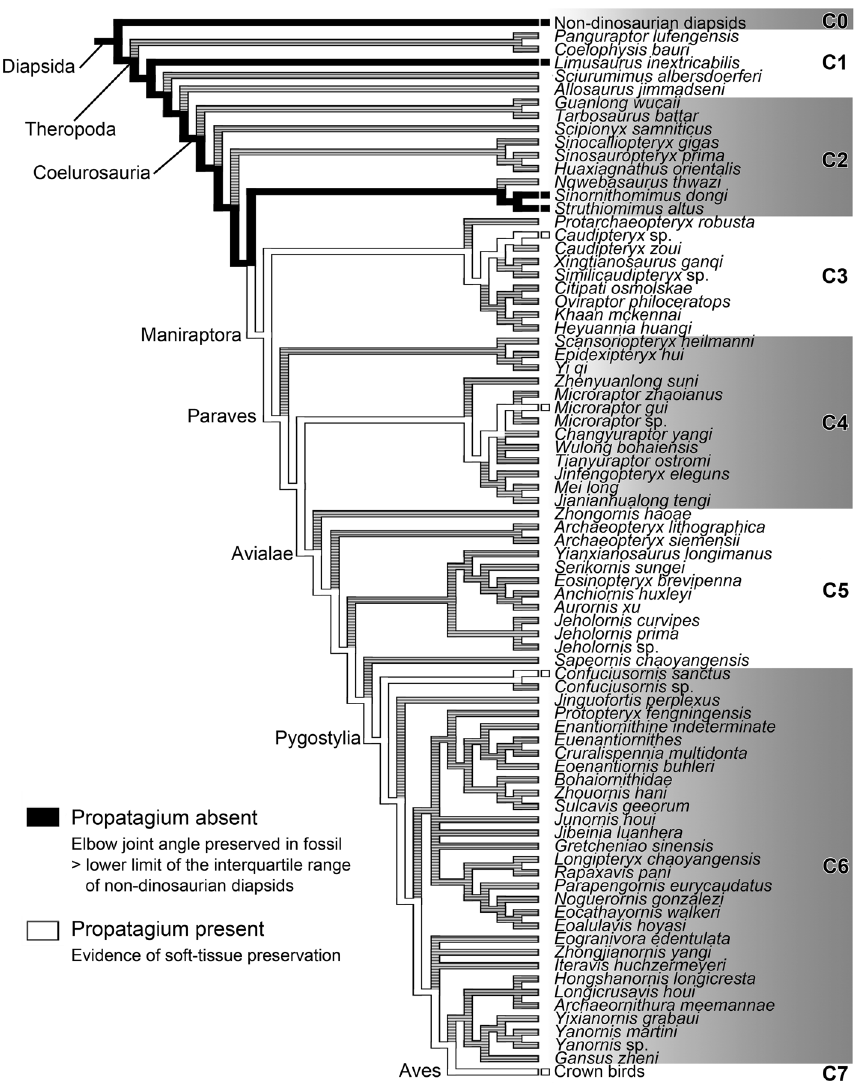
Fig. 4 Evolutionary process of the propatagium. The evolutionary process of the propatagium was inferred based on the elbow-joint angles preserved in fossils (evidence for absence) and soft-tissue preservation (evidence for